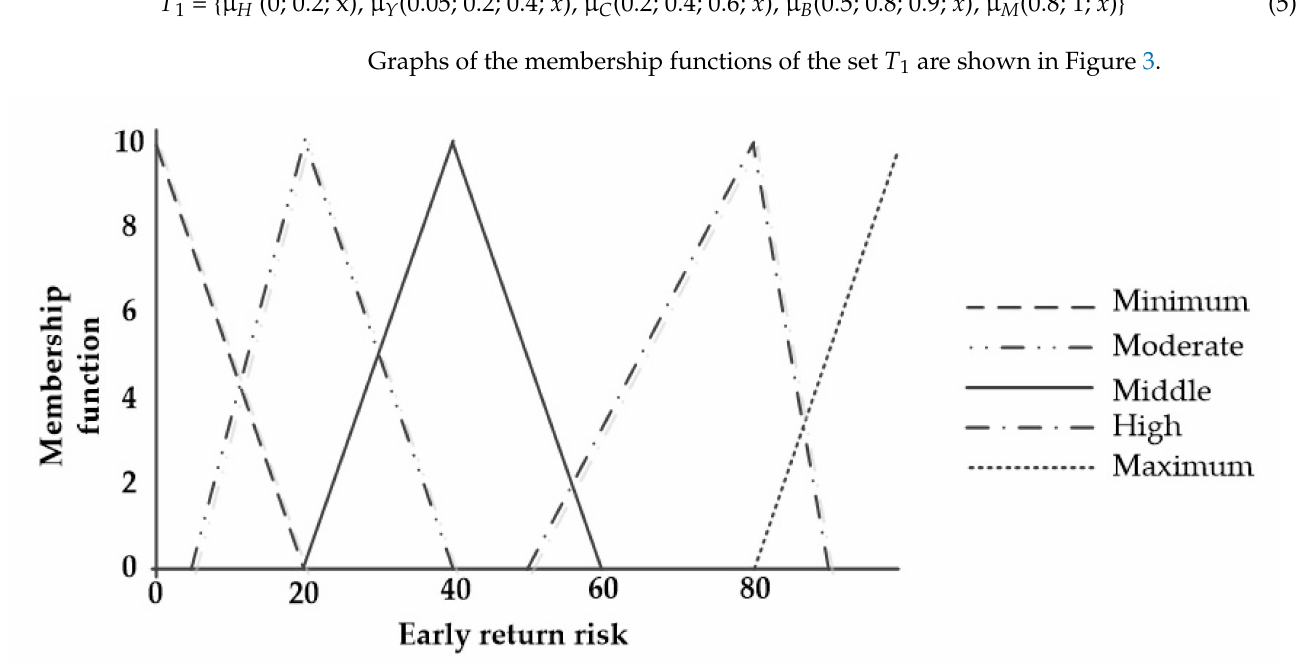
Figure 3. Graphs of membership functions of linguistic variables of the set T 1 .